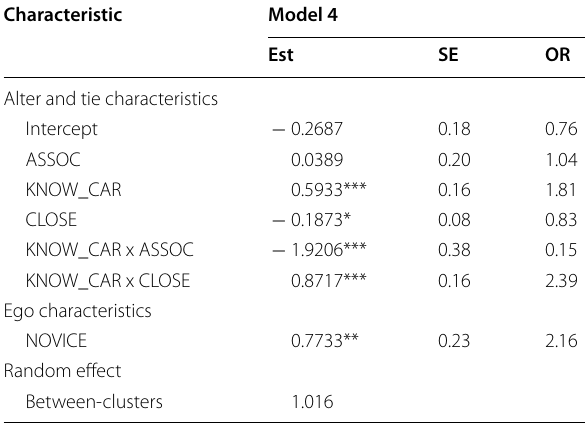
r Pearson correlation coefficient representing the correlation between = exposure to a Noyce program characteristic and the average number of mentor ties in a teacher’s network. n exp number of teachers exposed to a given = program characteristic. n 164 = * p < 0.05, ** p <